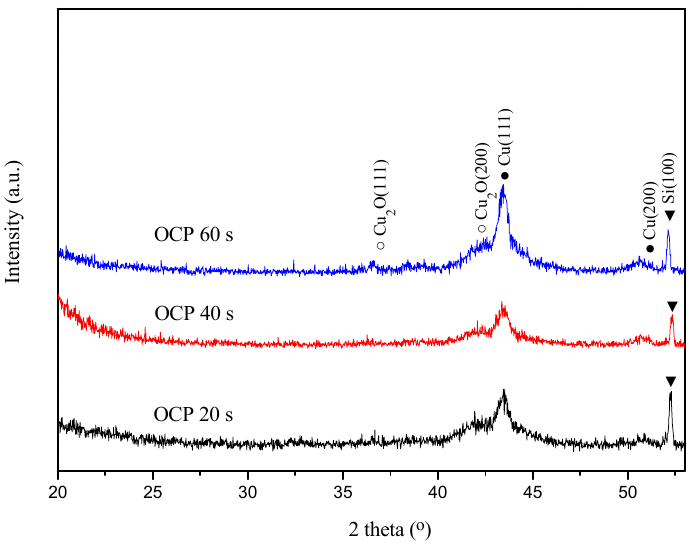
Figure 5. Surface morphologies of the Cu(Mn) films deposited in the Cu electrolytes, with various terminated OCP times of ( a ) 60 s, ( b ) 40 s, and ( c ) 20 s.